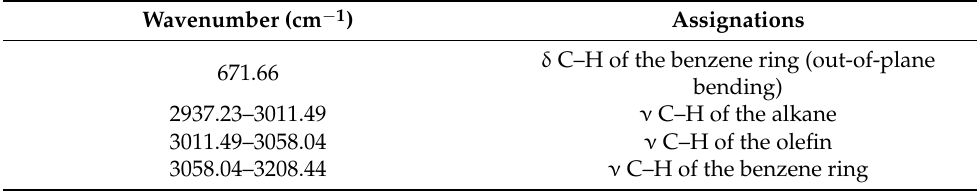
Figure 3. Molecular vibrational spectrums and bond length: ( a ) SBS IR, saturate IR, SBS–saturate IR; ( b ) C–H bond length of SBS. Table 1. Assignations of the bands of the SBS molecule vibration spectrum.